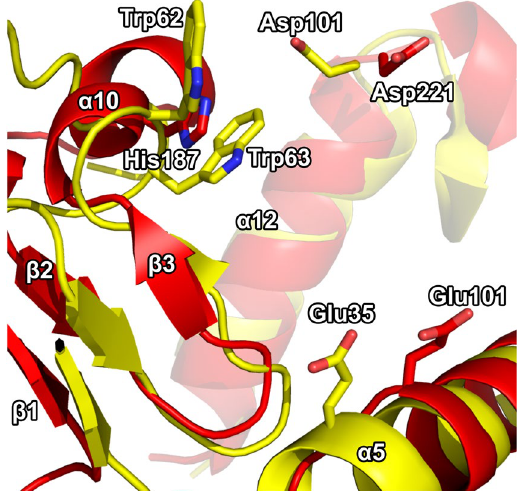
Figure 4. Structural alignment of AP3gp15 and HEWL loop region responsible for substrate recognition. Homologies between HEWL and AP3gp15 residues that are possibly involved in the substrate recognition and other interactions. Only the homologous catalytic Glu35 of HEWL is highlighted as it is represented by its counterpart residue of Glu101 in AP3gp15. Asp101 of HEWL plays a role in substrate positioning and its putative homologue is Asp221 of AP3gp15. The closest homologue of similarly functioning Trp62 and Trp63 of HEWL is represented by His187 that positions between these two amino acids in the structural